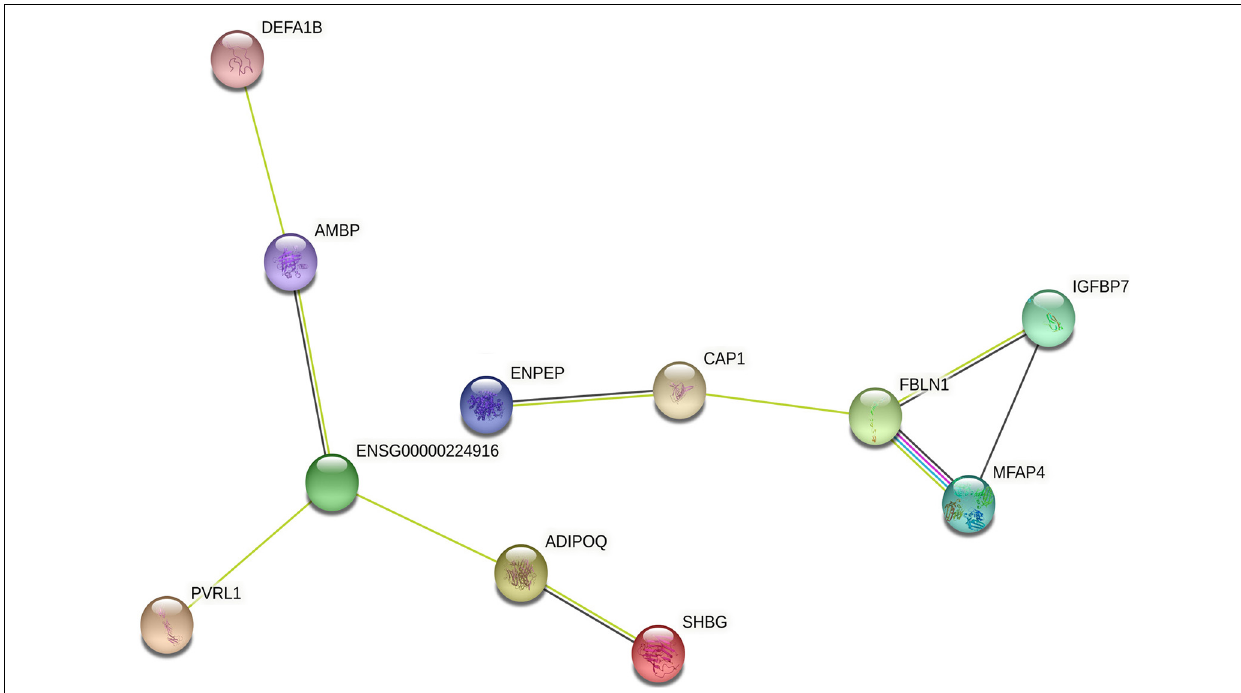
FIGURE 5 | The interaction network of differentially expressed proteins. The interaction network of differentially expressed proteins was analyzed using String database. Each node represents one differential protein, and each connection reflects the interaction of proteins. The color of lines between proteins indicates the source of connection scores: co-expression (dark), experimentally determined interaction (blue),; atabase annotated (pink), and automated text mining (green). The full names of the proteins are shown in Table 5